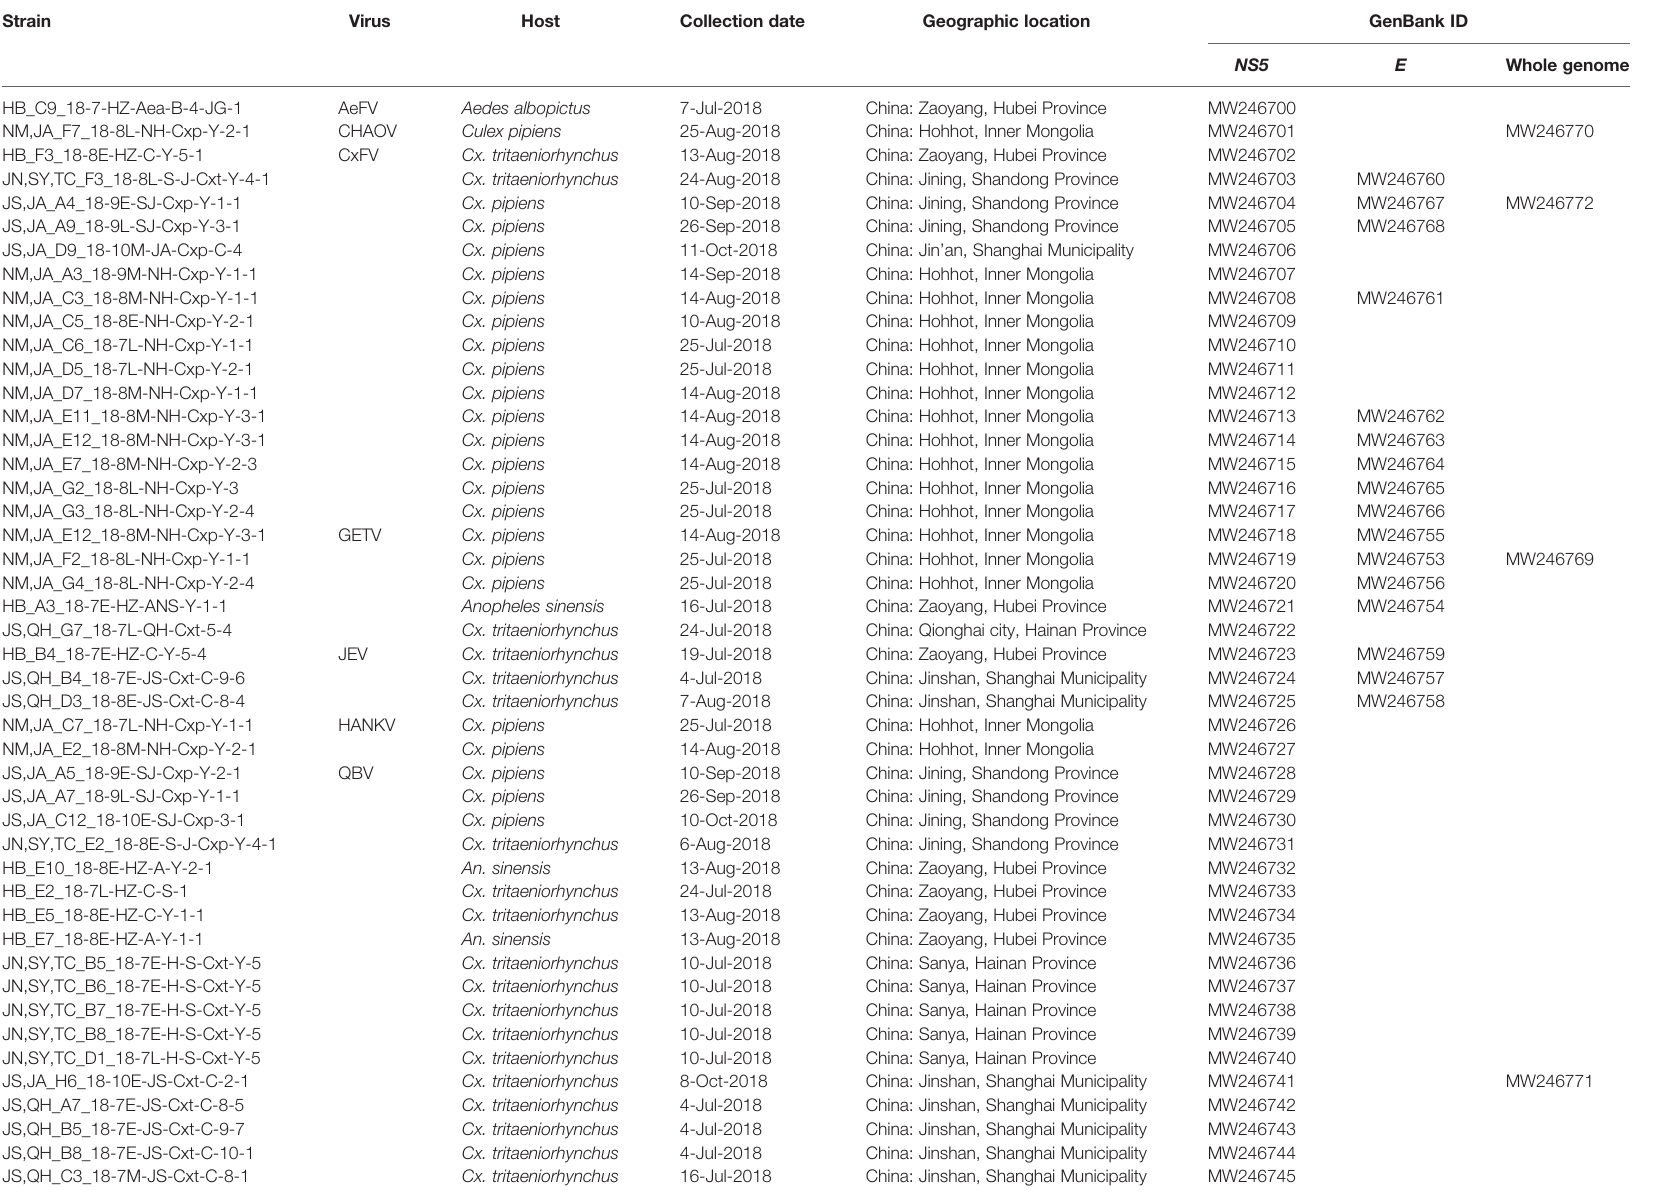
TABLE 1 | Mosquito-borne viruses detected at different sentinel sites during the mosquito activity seasons of 2018.